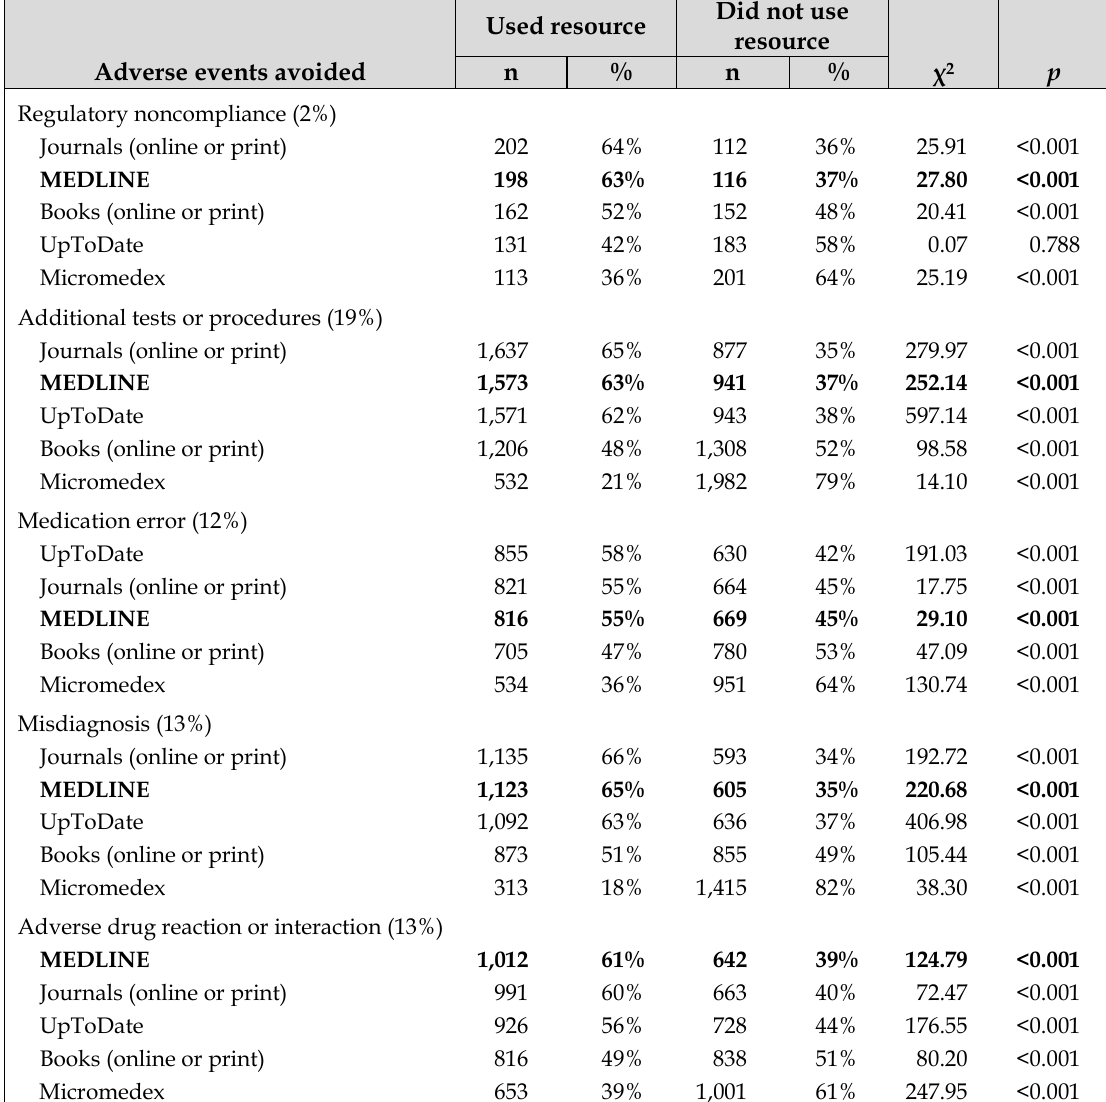
Table 3 Percent of respondents who used each information resource among those who avoided adverse events as a result of the information obtained in their searches